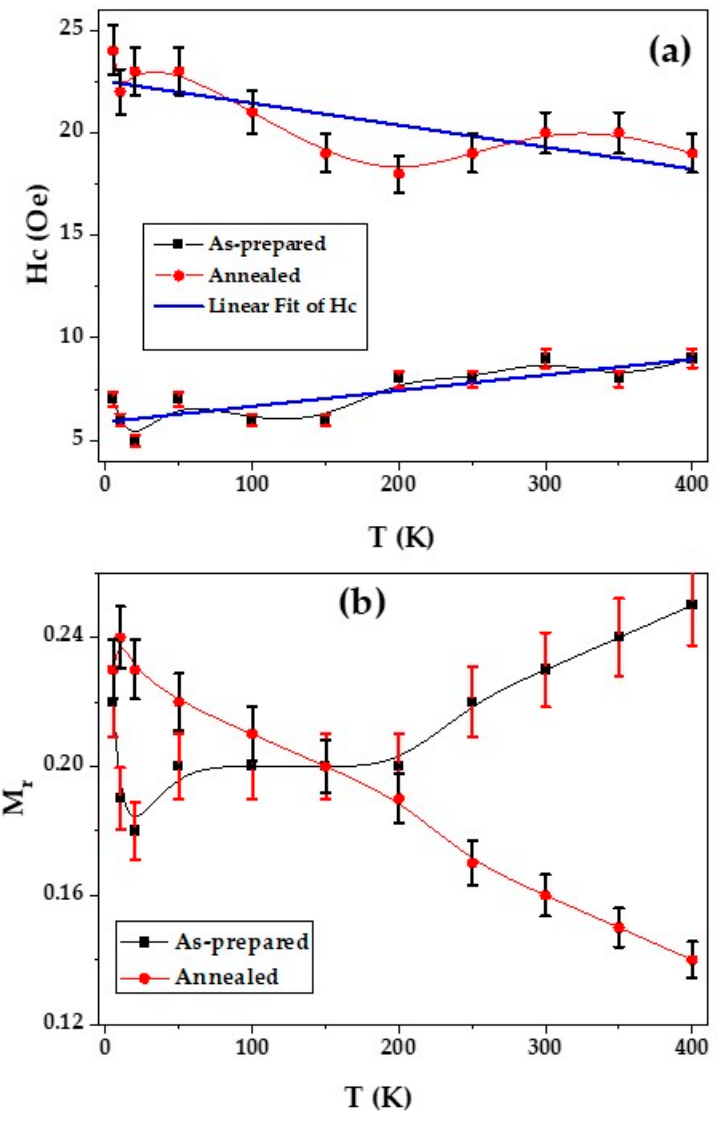
Figure 5. Coercivity (H c ) of Co 2 MnSi glass-coated microwires (the linear fitting of Hc is shown by blue lines.) ( a ) and normalized remanence (M r ) ( b ) dependence on temperature both in as-prepared samples and in samples annealed at 1023 K for 2 h.